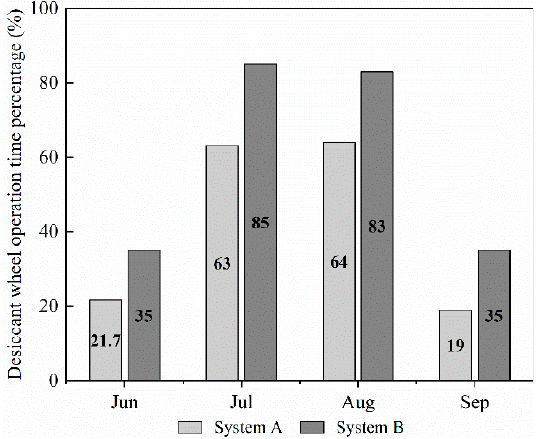
Figure 11. Desiccant wheel operation time percentage in the HPDC systems.